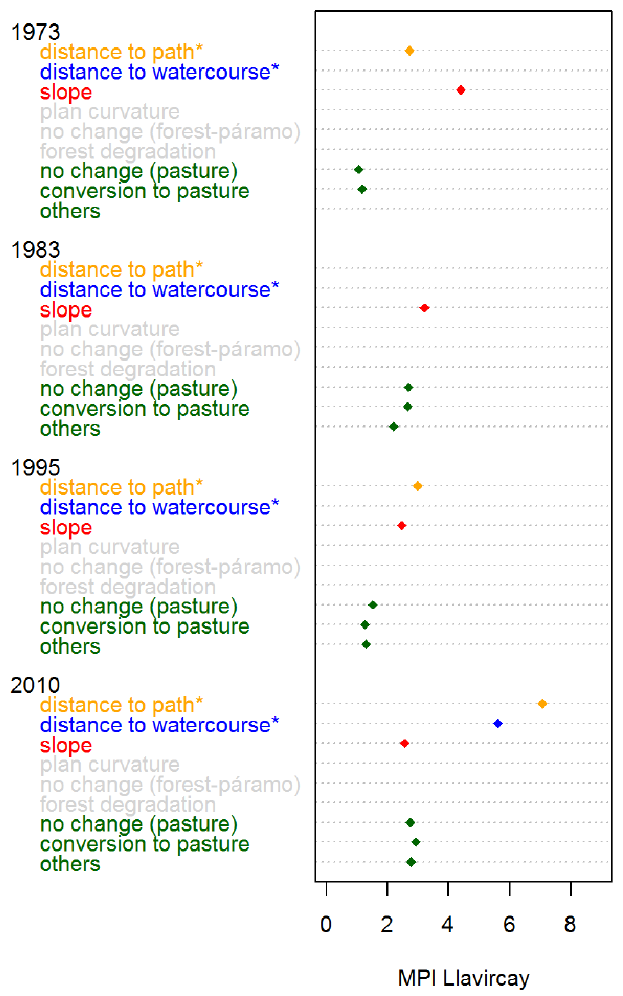
Fig. 4. Evolution of the most important controlling variables through time. For the variables with * we took the absolute value of measure parameter importance (MPI).